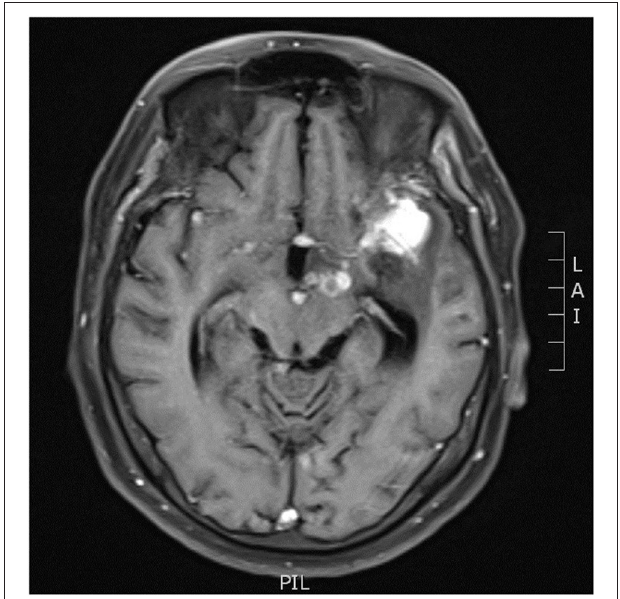
FIGURE 3 | MRI revealed nodular enhancement in the left pontine cistern.